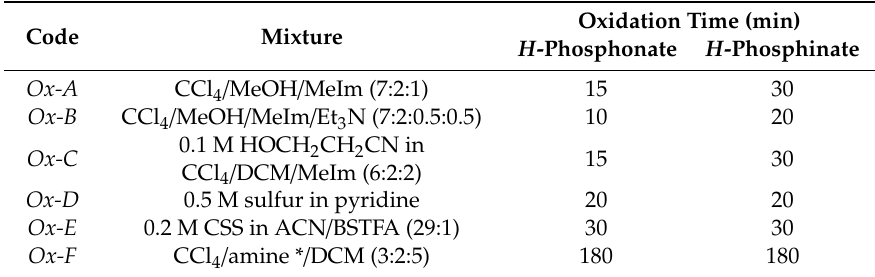
Table 1. The conditions of oxidation, sulfurization and amidation.